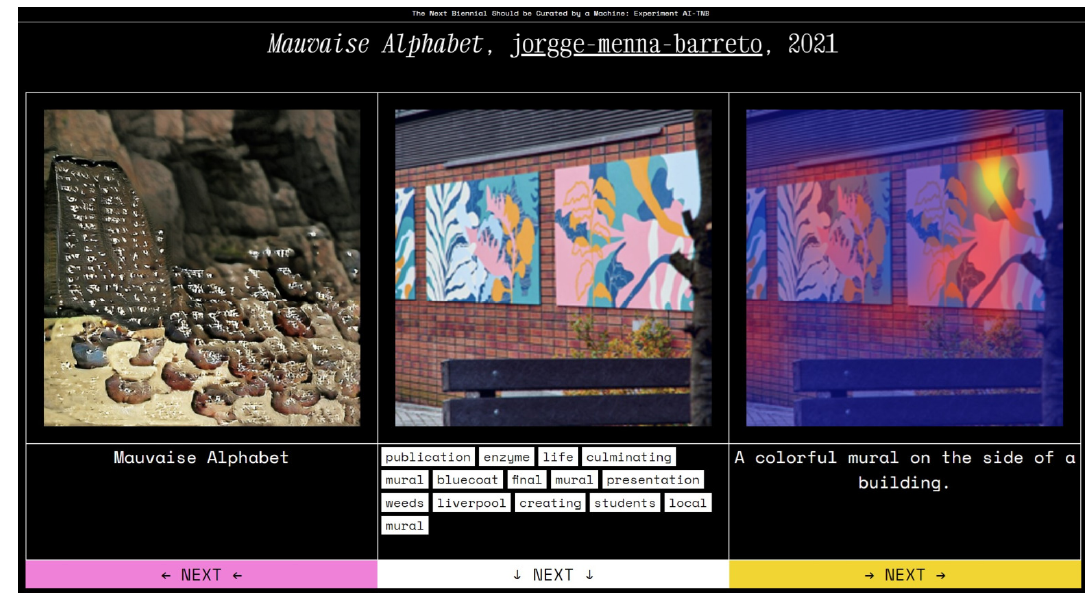
Figure 15. Triptych of the The Next Biennial Should be Curated by a Machine. On the right, a textual description generated from the visual features of the image on top is shown. Joasia Krysa, Leonardo Impett and Eva Cetinic. The Next Biennial Should Be Curated by a Machine. Experiment: AI-TNB. Available online: https://metaobjects.org/testing/liverpoolbiennial/ (accessed on 18 July 2022) (screenshot).